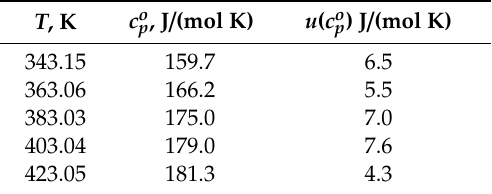
Table 4. Ideal-gas heat capacity at constant pressure data for HFE-356mmz.